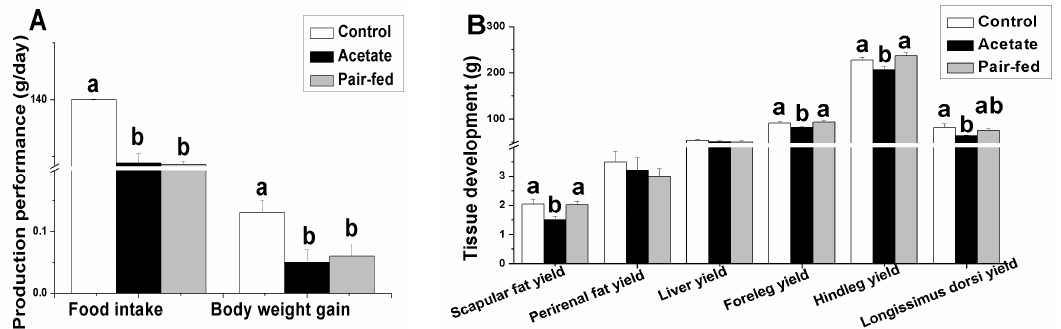
Figure 1. The effect of acetate administration on production performance ( A ) and tissue development ( B ). a, b: means with different superscripts are significantly different ( p < 0.05).